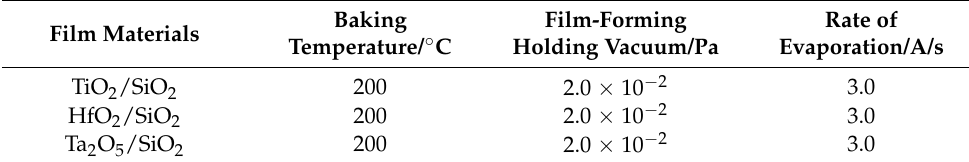
Table 1. Thin film deposition process